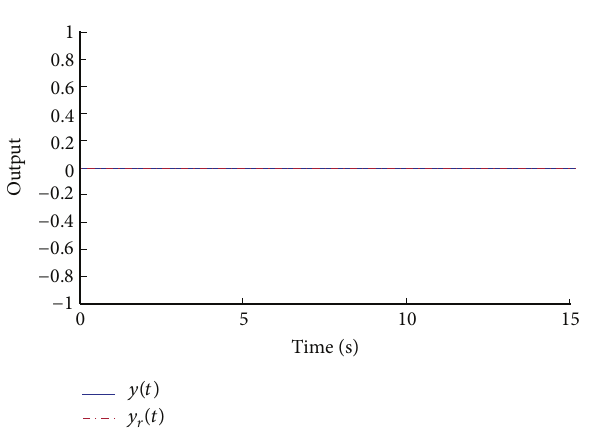
Figure 3: System output tracking trajectory with zero initial condition.